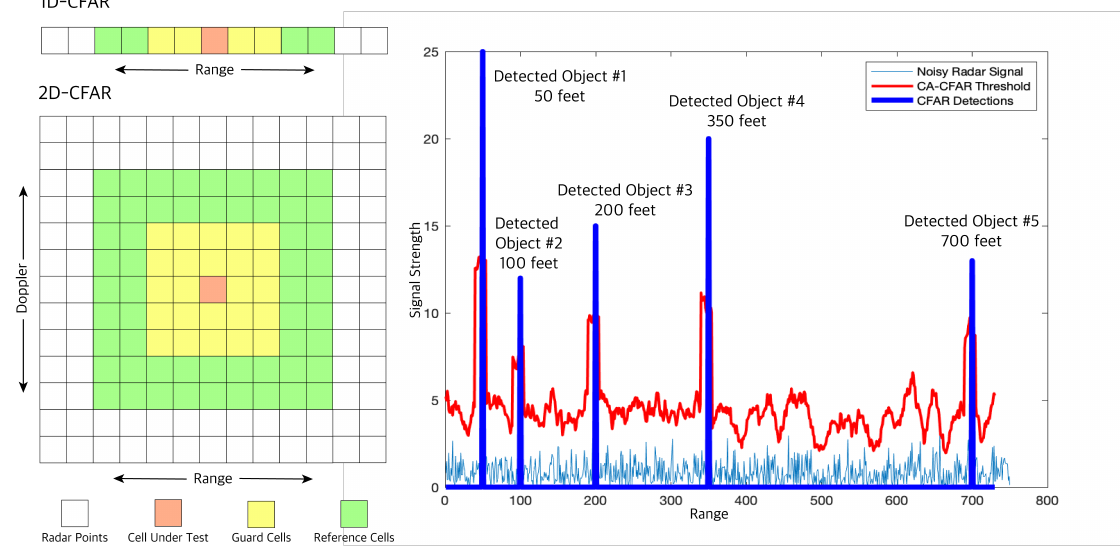
Figure 10. 1D and 2D-CFAR sample windows (left) with 1D-CFAR multi object detection (right). The plot shows signal strength vs. range. Five objects are detected (the blue peaks) at ranges 50, 100, 200, 350 and 700